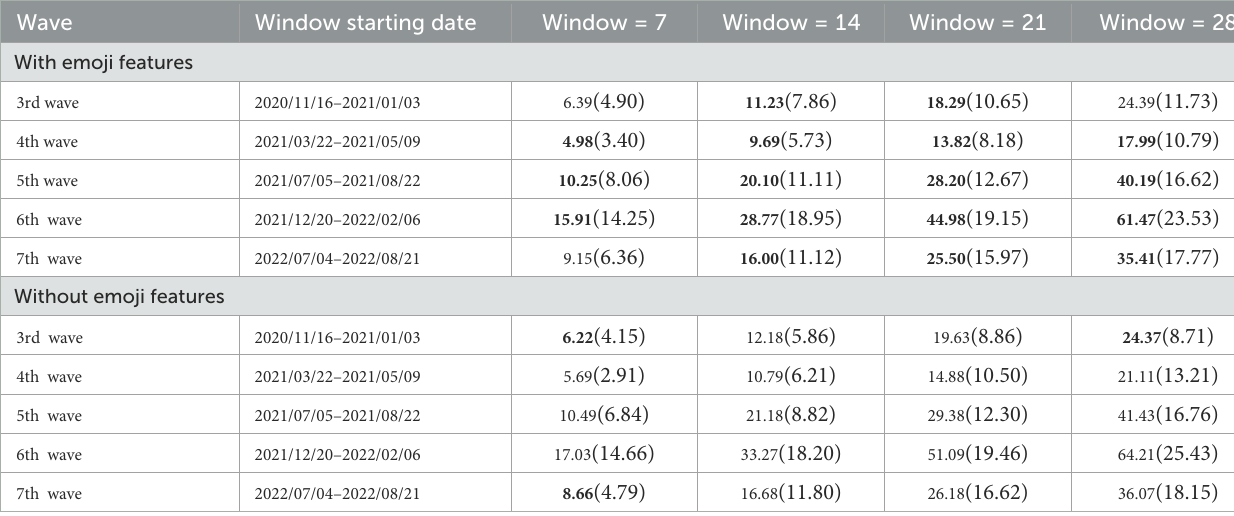
TABLE 2 COVID-19 case prediction system performance with and without use of emoji for each wave.